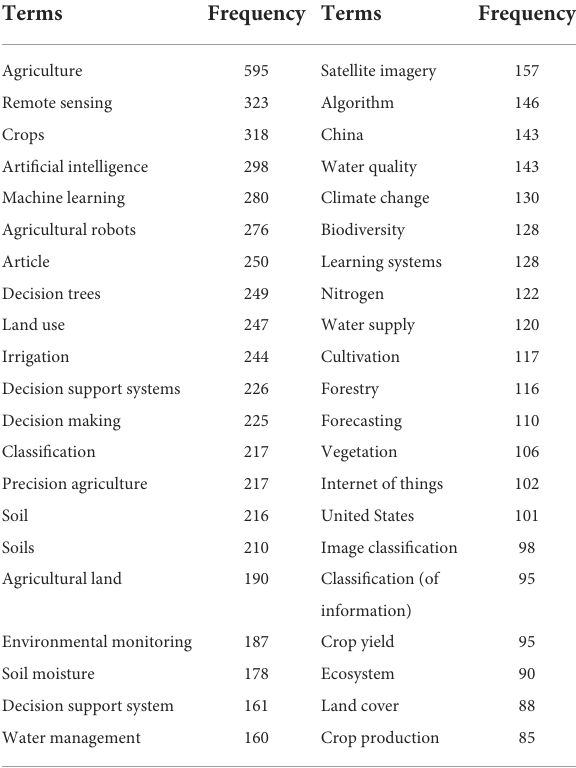
TABLE 5 Table of most frequently used